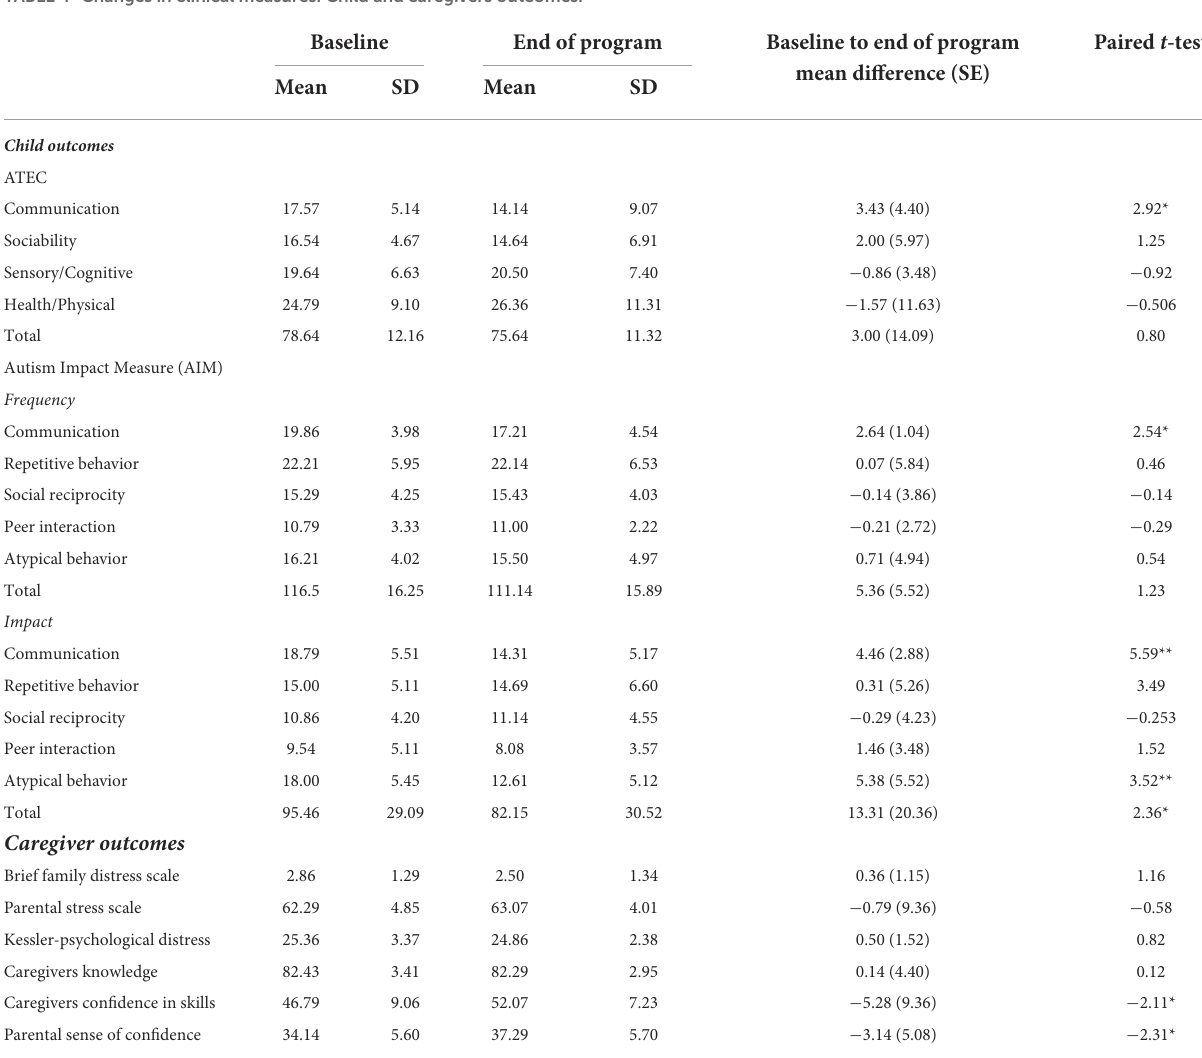
TABLE 4 Changes in clinical measures: Child and caregivers outcomes. Baseline End of program Baseline to end of program